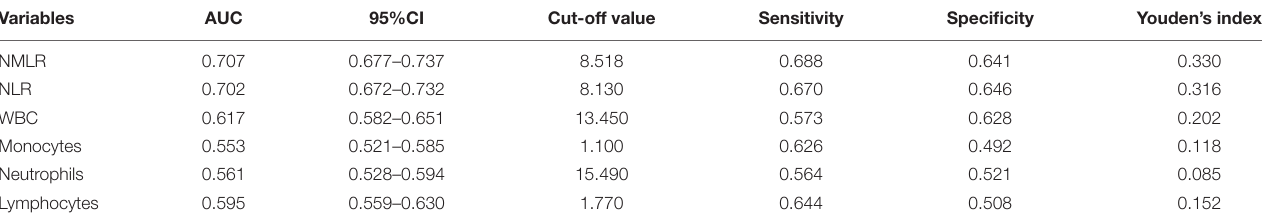
TABLE 3 | Information of ROC curves in Figure 2 .